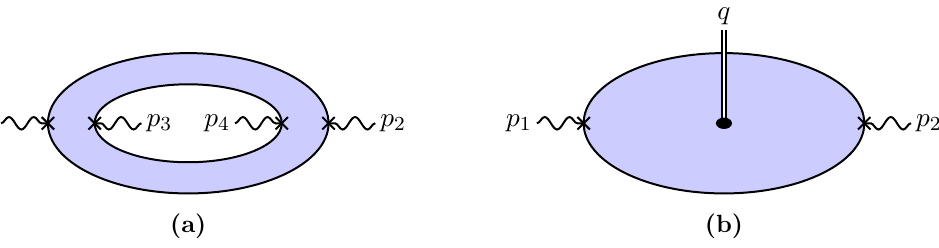
Figure 3. ( a ) Worldsheet con(cid:12)guration for a four-point double-trace amplitude. Each (cid:2) stands for the insertion of an open string vertex operator. ( b ) Worldsheet con(cid:12)guration for the Sudakov form factor. The (cid:15) stands for the closed string vertex operator.